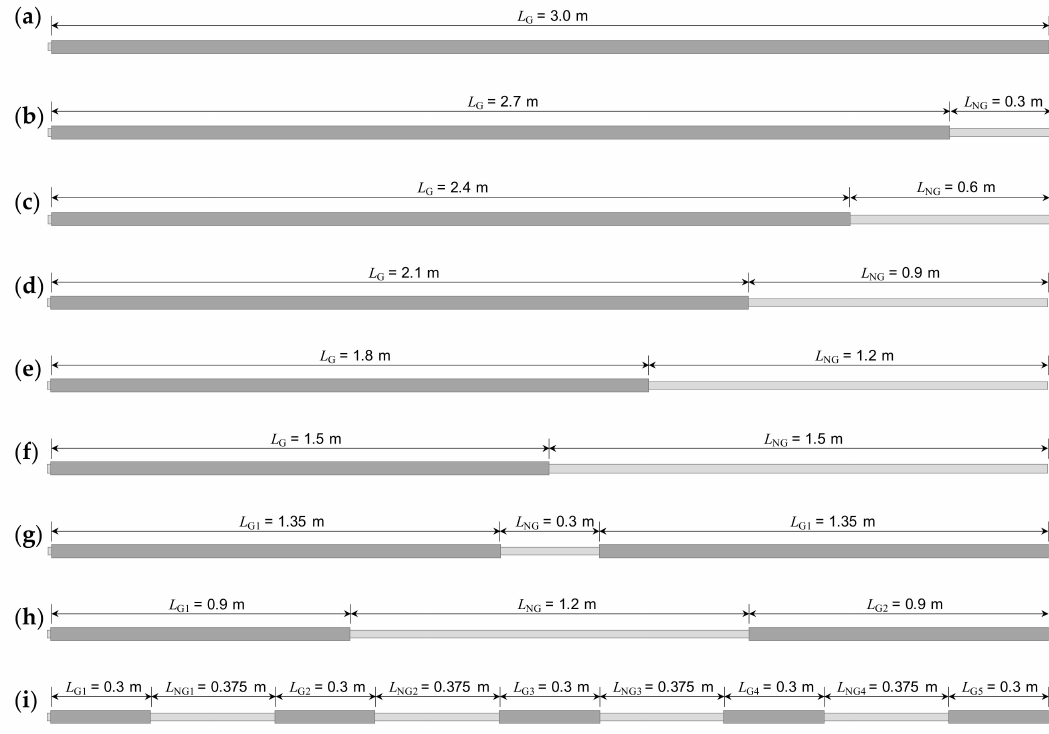
Figure 7. Schematic diagram of rock bolt specimens in non-embedded condition: ( a ) F0 (NGR = 0%); ( b ) D1 (NGR = 10%); ( c ) D2 (NGR = 20%); ( d ) D3 (NGR = 30%); ( e ) D4 (NGR = 40%); ( f ) D5 (NGR = 50%); ( g ) V1 (NGR = 10%); ( h ) V4 (NGR = 40%); ( i ) V5 (NGR = 50%). NGR: non-grouted